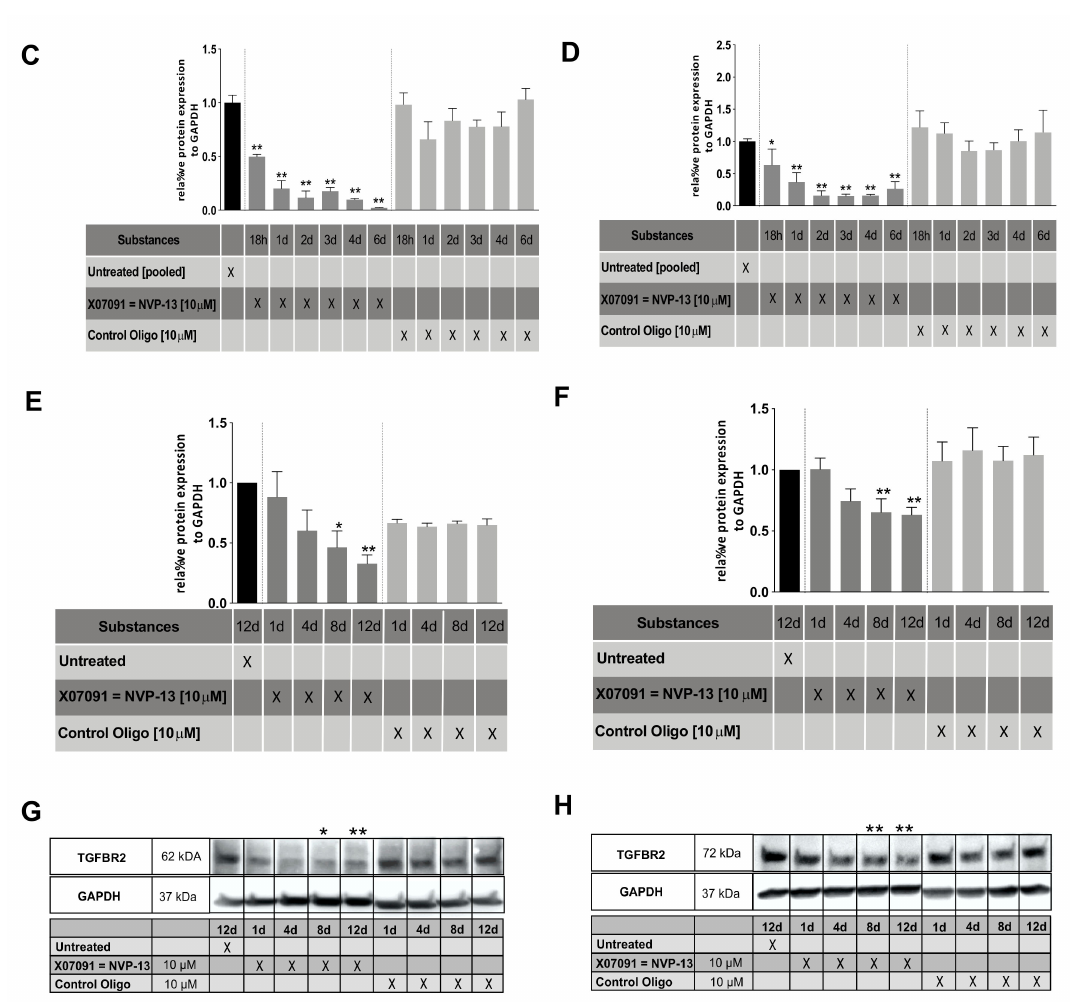
Figure 5. Cellular uptake, mRNA and protein kinetics of lead candidate X07091 = NVP-13. ( A and B ) Cellular uptake kinetics of A549 ( A ) and ReNcell CX ® ( B ) cells after 0–72 h of incubation with 10 µ M X07091 = NVP-13 as measured with a specific bioprobe ( n = 3). ( C and D ) TGFBR2 mRNA kinetics in A549 ( C ) and ReNcell CX ® ( D ) established in a qRT-PCR over 6 d after a single treatment with 10 µ M X07091 = NVP-13 ( n = 3). TGFBR2 mRNA levels were normalized to the housekeeper Gnb2l and normalized to untreated cells. ( E and F ) Densitometric analysis of TGFBR2 protein levels (Western blot) in A549 ( E ) and ReNcell CX ® ( F ) after 1, 4, 8, and 12 d of treatment with 10 µ M X07091 = NVP-13 (n = 4 for A549 and n = 7 for ReNcell CX ® ). ( G and H ) Western Blot (WB) against TGFBR2 (Biorybt) in A549 ( G ) and ReNcell CX ® ( H ). For qRT-PCR and WB, all values were normalized to untreated controls. Statistics was calculated by Ordinary-one-way-Anova followed by Dunnett’s multiple comparison test. * p ≤ 0.05, ** p ≤ 0.01, ± =